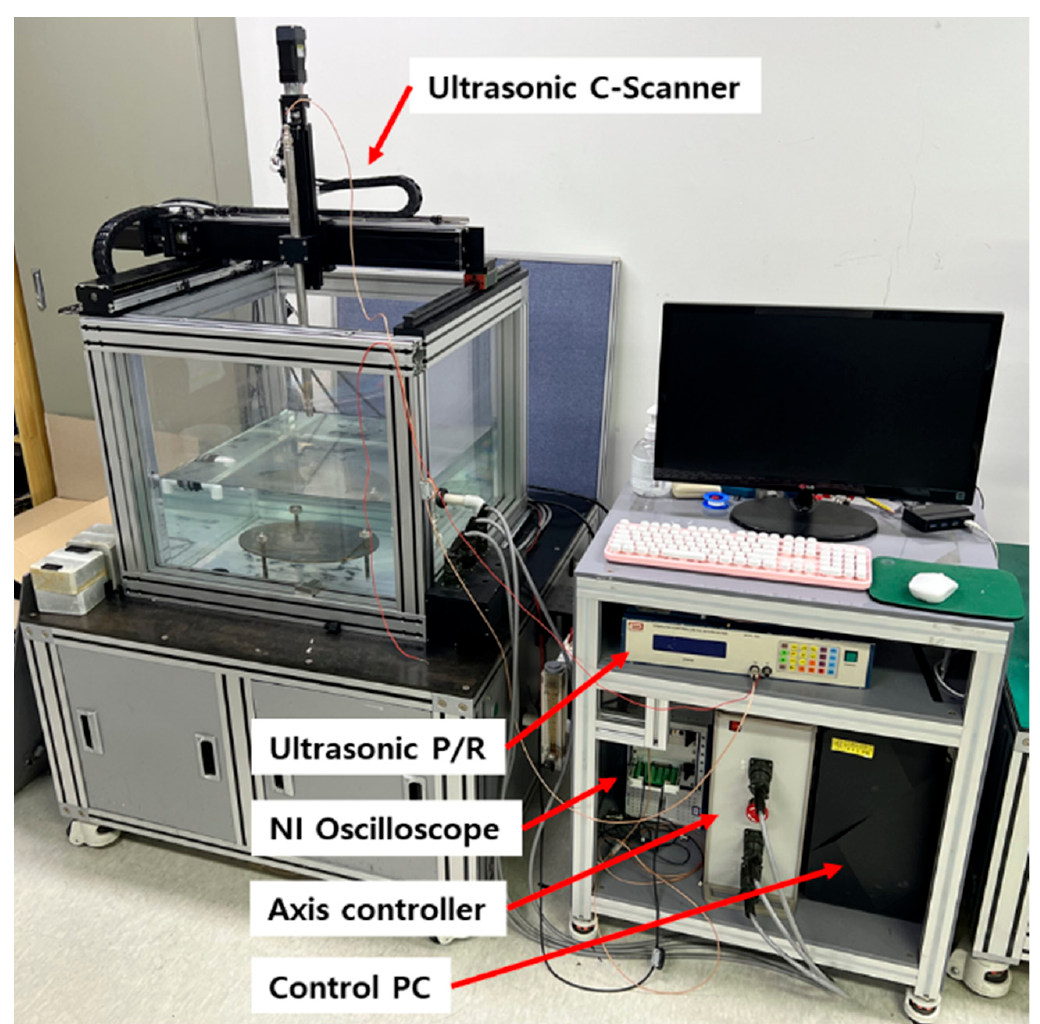
Figure 4. Ultrasonic C-scanner used in this study.